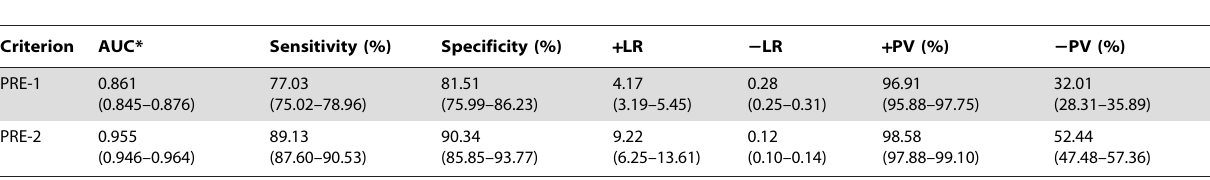
Table 3. The efficiency for detecting OSA with PRE-1 and PRE-2 versus PSG in the test cohort (n =2,032).